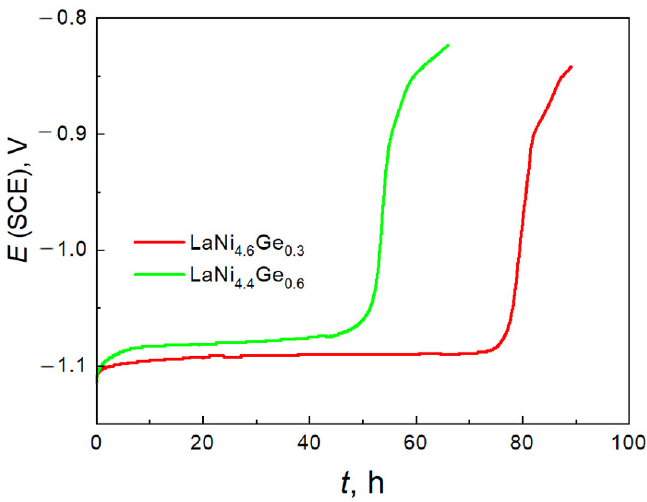
Figure 8. OCP vs. time for the hydrogen charged electrodes (6 M KOH, charge conditions: 185 mA g −1 , 2 h).